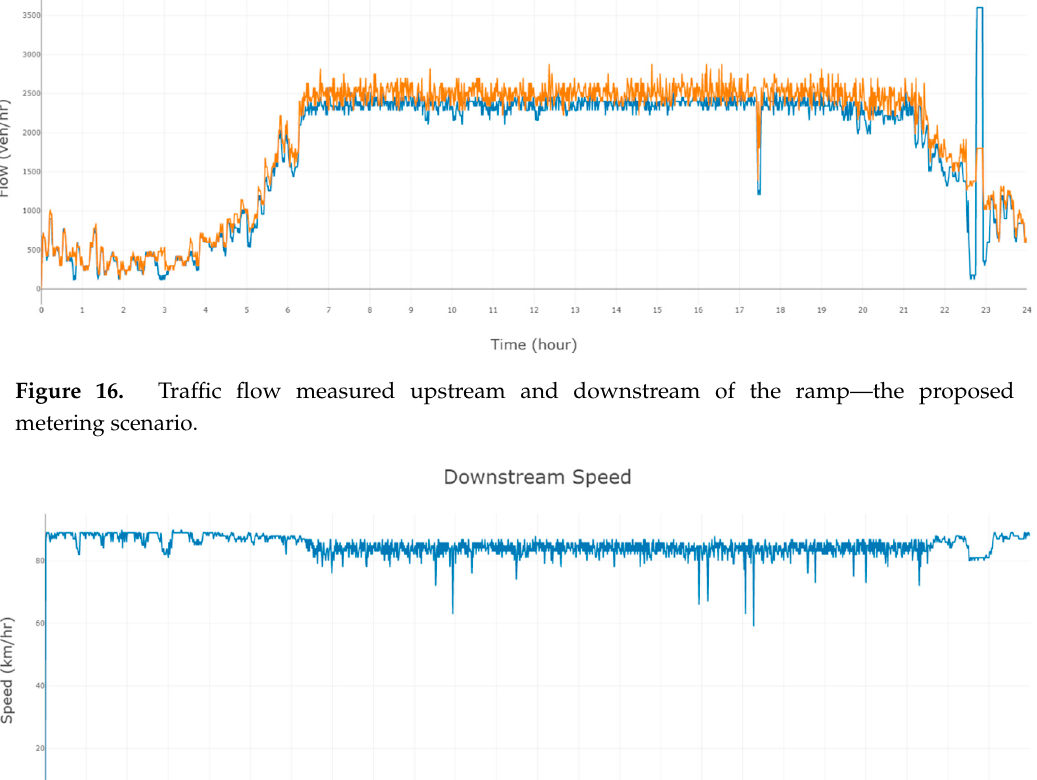
Figure 17. Average speed measured downstream of the ramp—the proposed metering scenario.